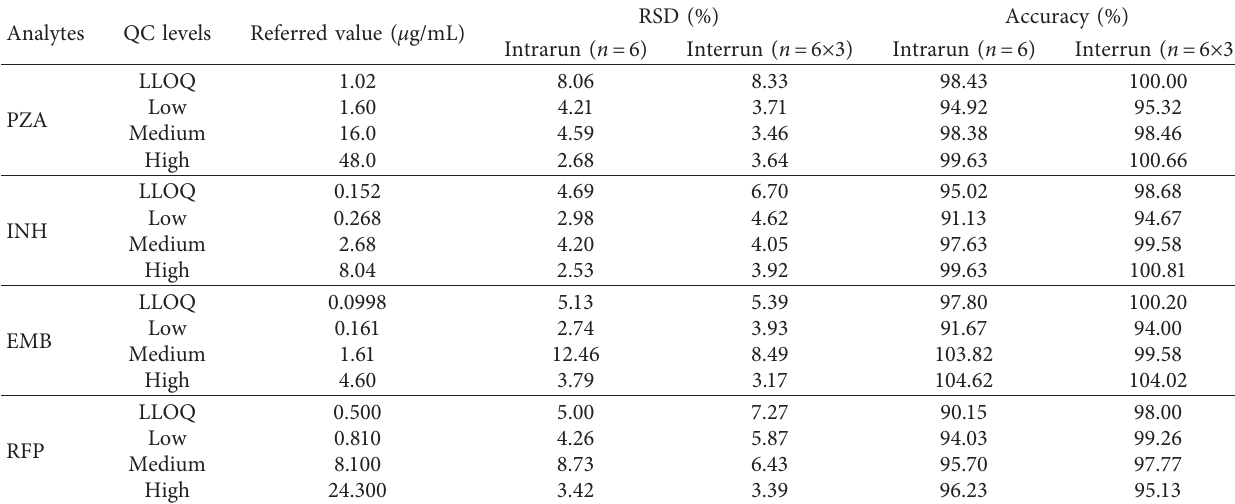
Table 3: Precision and accuracy of the method at four concentration